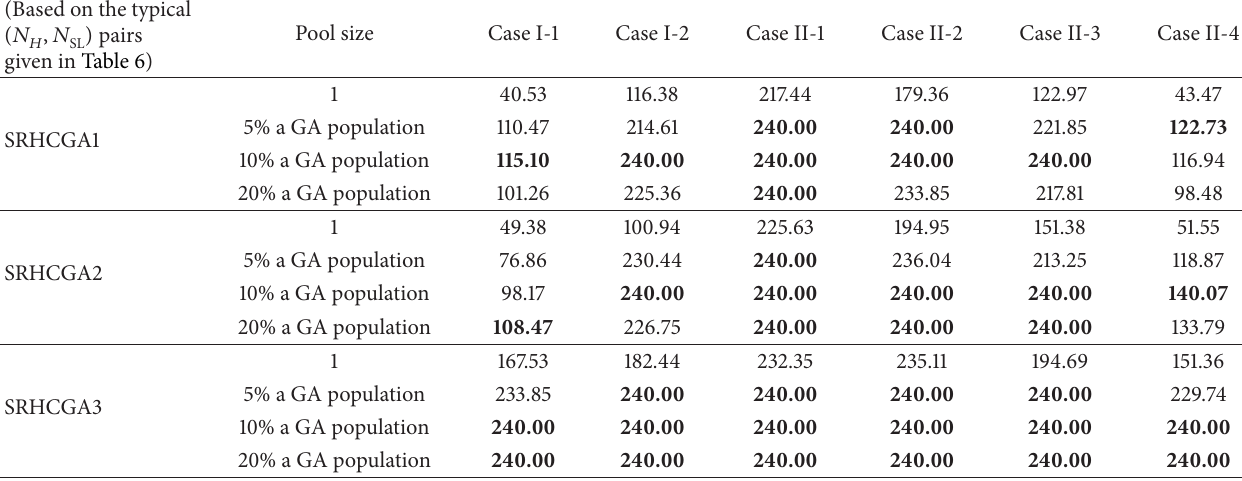
Table 8: The influence of pool size on performance of